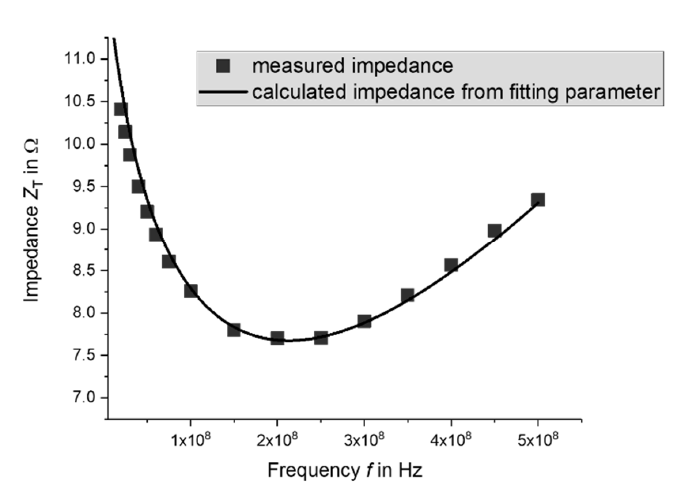
Figure 7. Measured frequency characteristic of the total impedance Z T of the device and impedance characteristic calculated from the lumped sum equivalent circuit obtained by fitting.